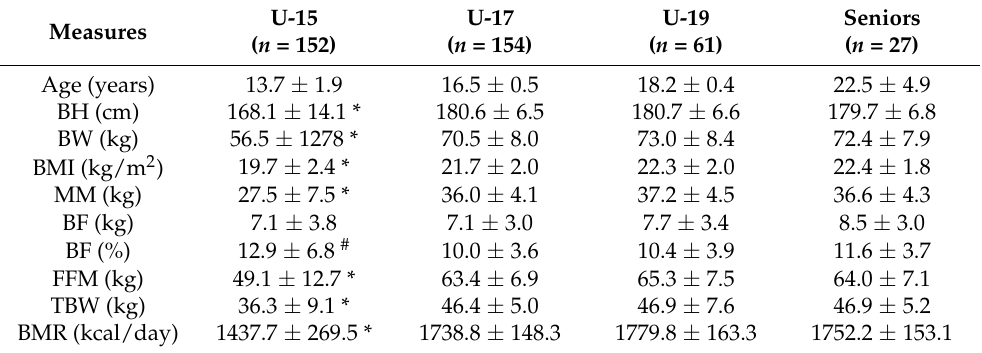
Table 1. Body height, weight and composition across age-related categories of soccer players. Measures